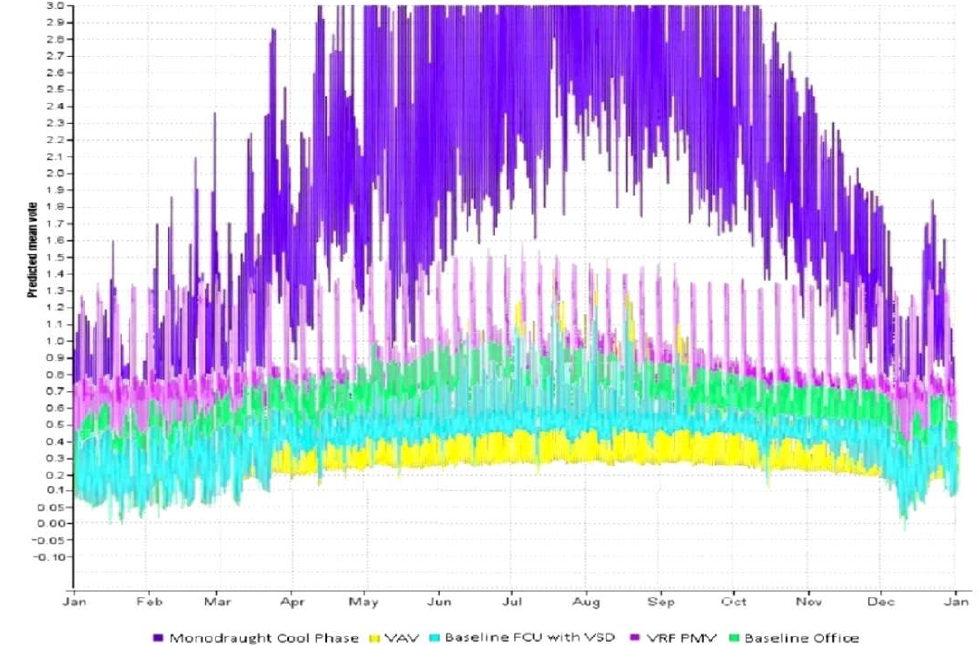
Figure 7. Trend in annual PMV for different cooling systems.